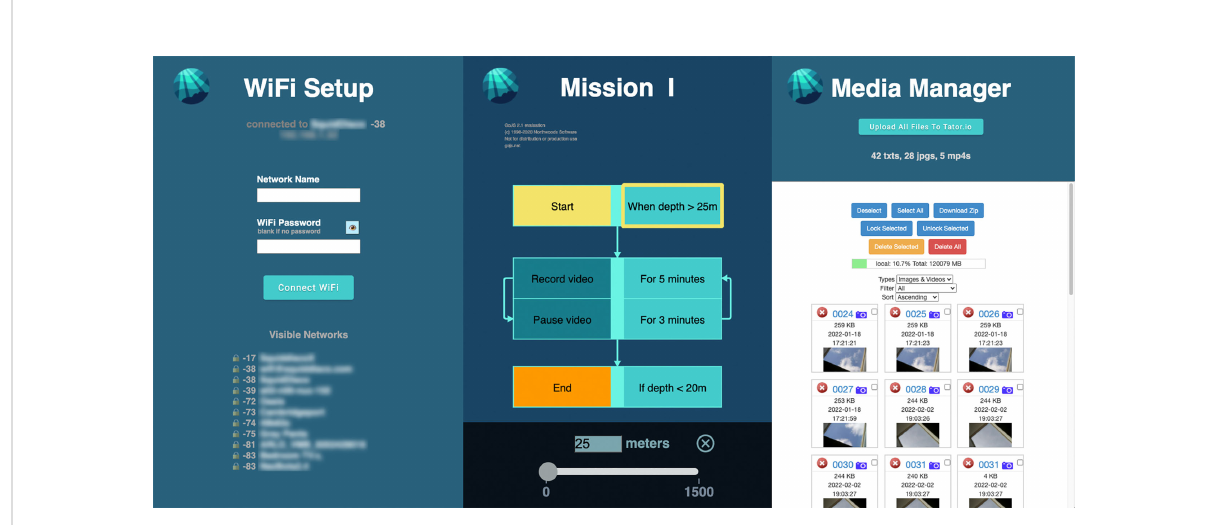
FIGURE 7 The Node.js Express web-based mission programming graphical user interface